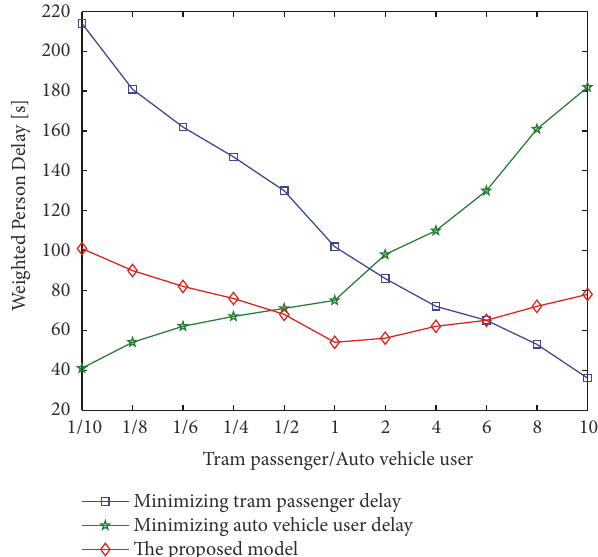
Figure 9: Performance on different ratio of tram passenger to auto vehicle user with different